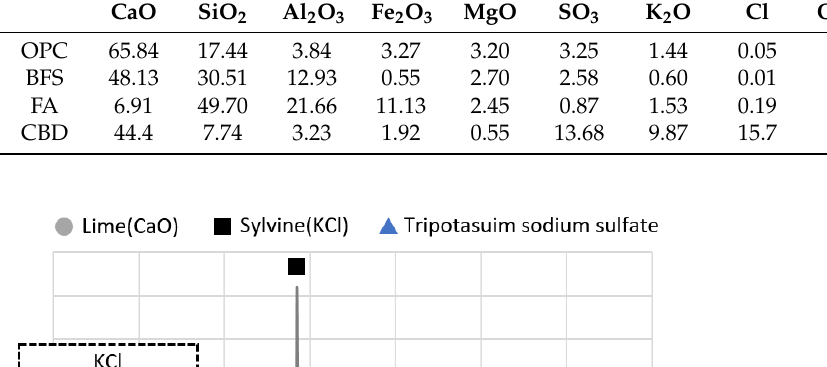
Table 3. Chemical composition of the binders and the CBD used in this experiment.